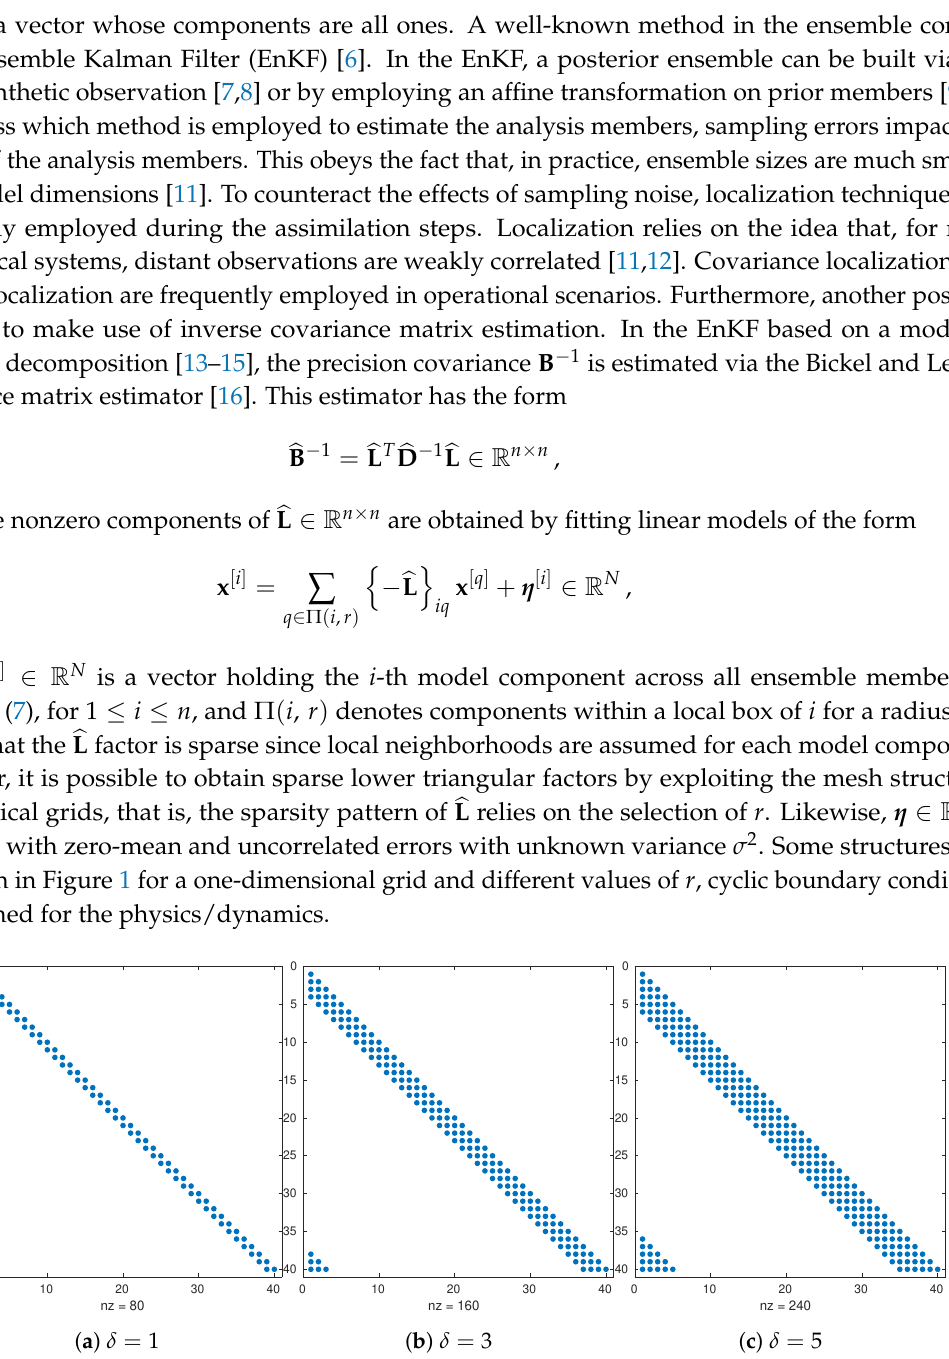
Figure 1. Structure of the Cholesky factor (cid:98) L k as a function of the localization radius r